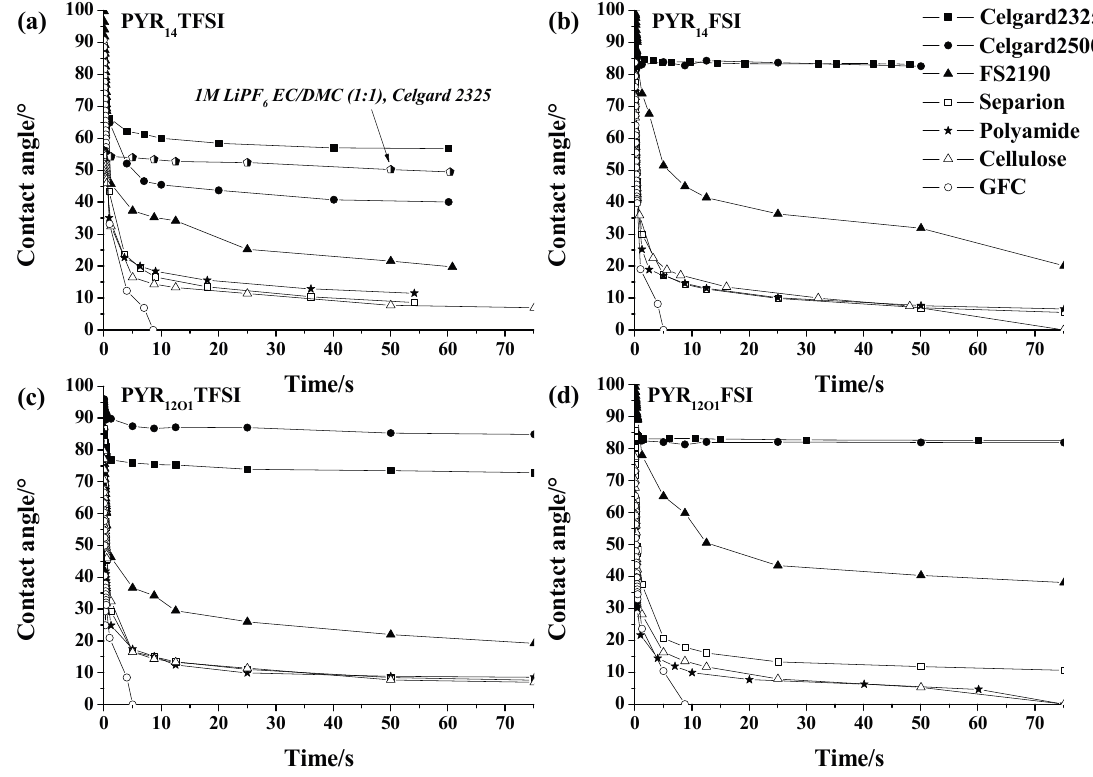
Figure 2. Evolution of the contact angle of drops of 10 mol % LiTFSI electrolytes deposited on the separators: ( a ) PYR TFSI (1M LiPF in EC:DMC (1:1) + Celgard ® 2325 14 6